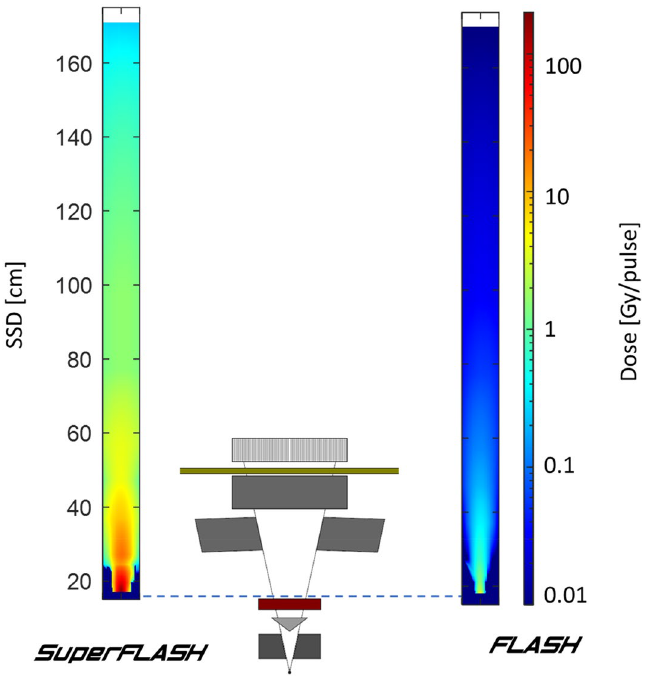
Figure 10. Heat map of dose rate in the two operation modes, adapted from 33 , with permission from Elsevier.